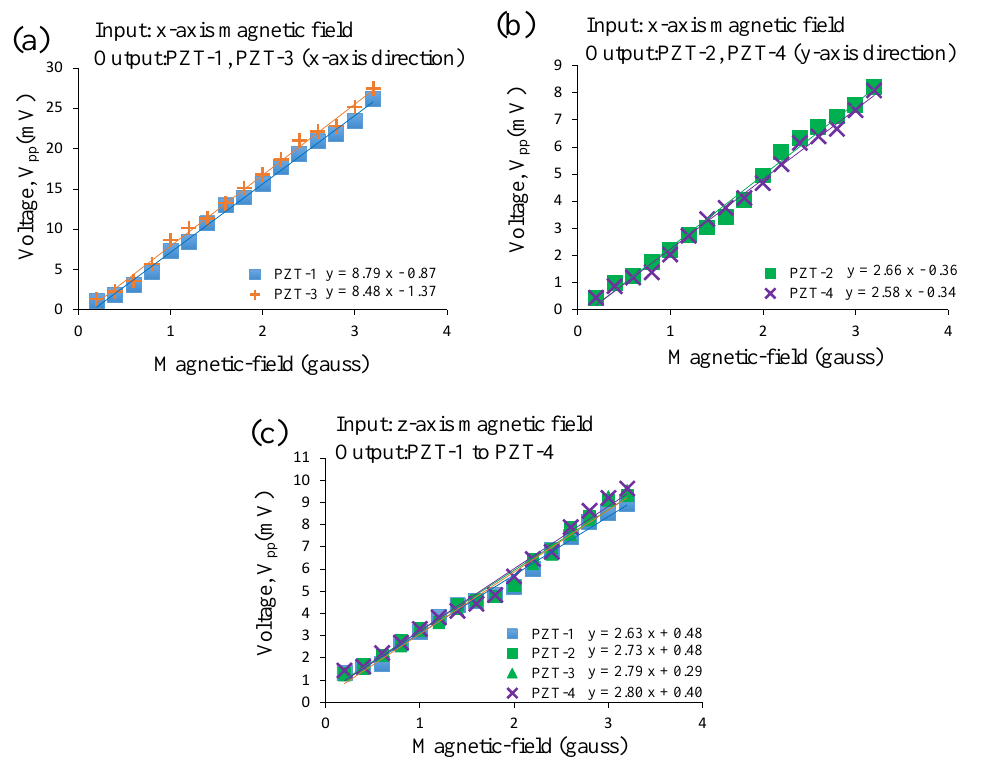
Figure 7. Experimental results of the performance test of the AC magnetic sensor. The voltage outputs of the AC magnetic sensor under: ( a , b ) the x -axis magnetic fields (sine-wave, 100 Hz, 0.2–3.2 gauss), and ( c ) the z -axis magnetic fields (sine-wave, 142 Hz, 0.2–3.2 gauss). The sensitivity of our magnetic-force-interaction-based AC magnetic sensor, and other representative magnetic-force-interaction-based magnetic sensors, are summarized in Table 2 for comparison. Because the volume of each sensor is different and the voltage output is proportional to